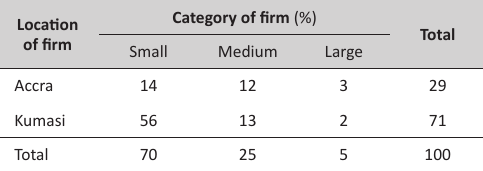
TaBLe 1. Respondents sampled from the various categories of firms in Accra and Kumasi